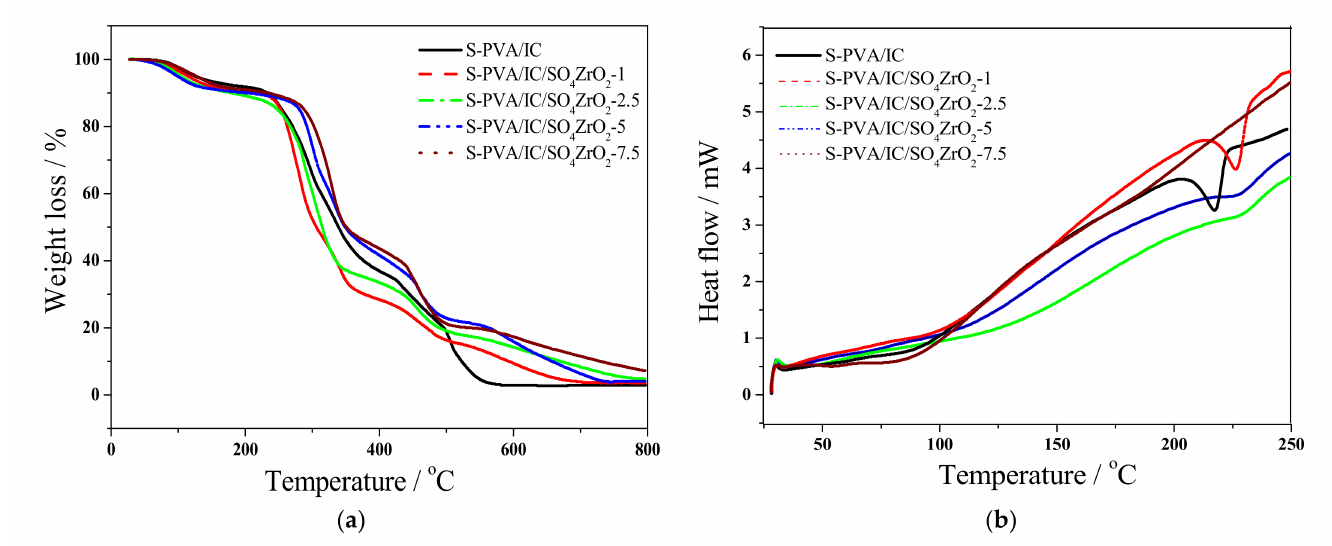
Figure 4. ( a ) TGA and ( b ) DSC curves of nanocomposite